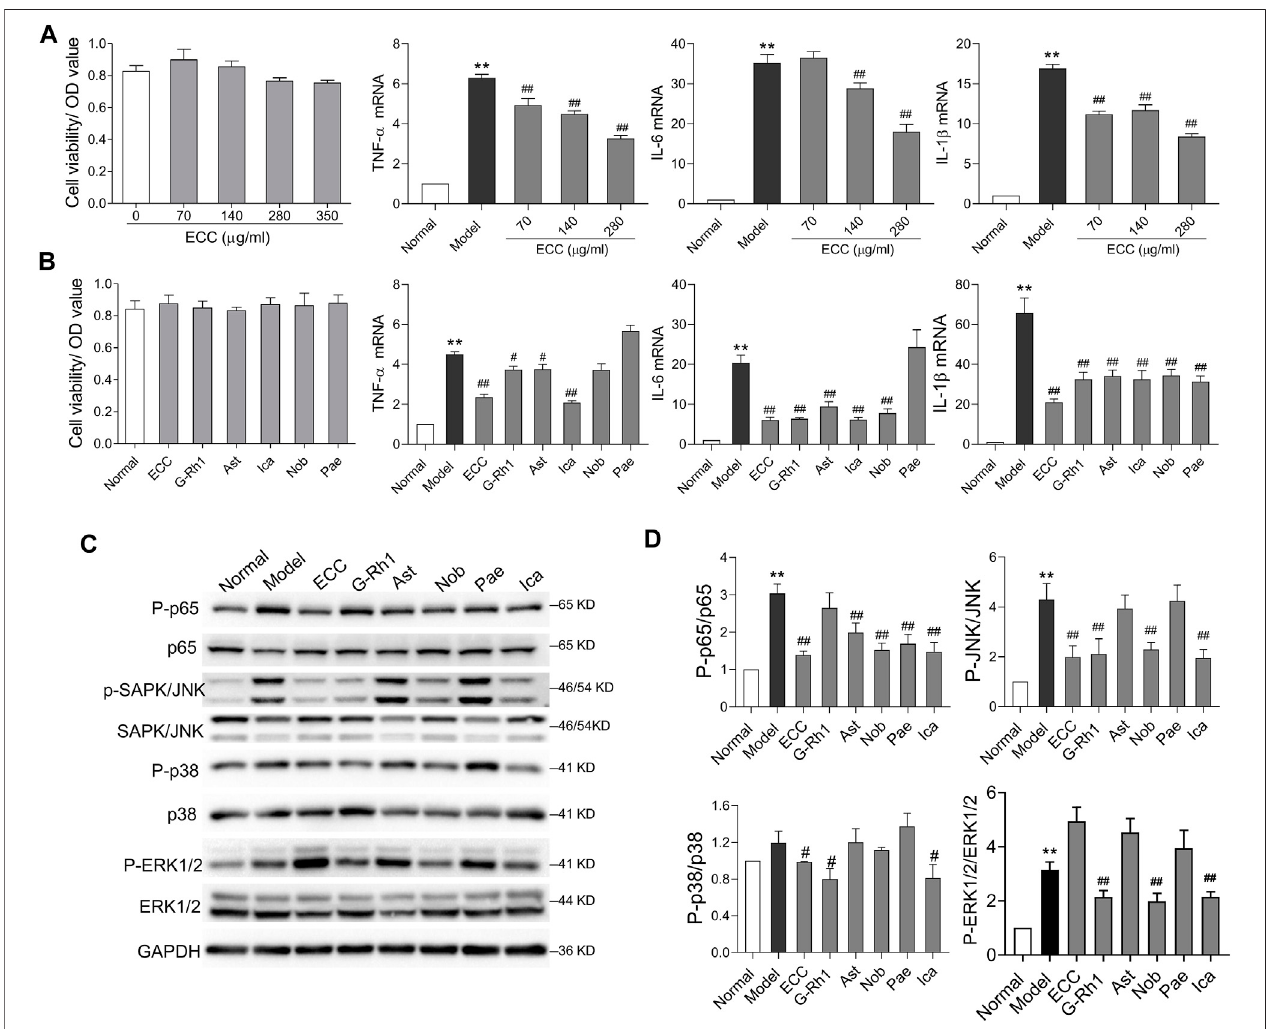
FIGURE8| ECCsuppressedcytokinelevelsandactivationofNF-kB andMAPKsignaling.MacrophagesweretreatedwithLPS(100 ng/ ml)and/orECC(70,140, and 280 μ g/ ml), 20-S-ginsenoside Rh1 (G-Rh1, 78.26 μ M), astragaloside IV (Ast, 12.74 μ M), icariin (Ica, 295.55 μ M), nobiletin (Nob, 19.88 μ M), and paeonol (Pae, 75.22 μ M) for 6 h. (A) Effectof ECC on cell viability and mRNA levels ofTNF- α , IL-6, and IL- β . (B) Effectof ECC and compounds on cell viability and cytokine mRNA. (C) Detection of p-p65, p65, p-p38 (T180/Y182), p38, p-SAPK/JNK, SAPK/JNK, p-ERK1/2 (T202/185), and ERK1/2 via Western blotting. Data are presented as the mean ± SEM, n (cid:2) 3. vs . normal ** p < 0.01, vs . model ## p < 0.01, # p < 0.05. (D) Quanti fi cation of p-p65/p65, p-p38/p38, p-JNK/JNK,